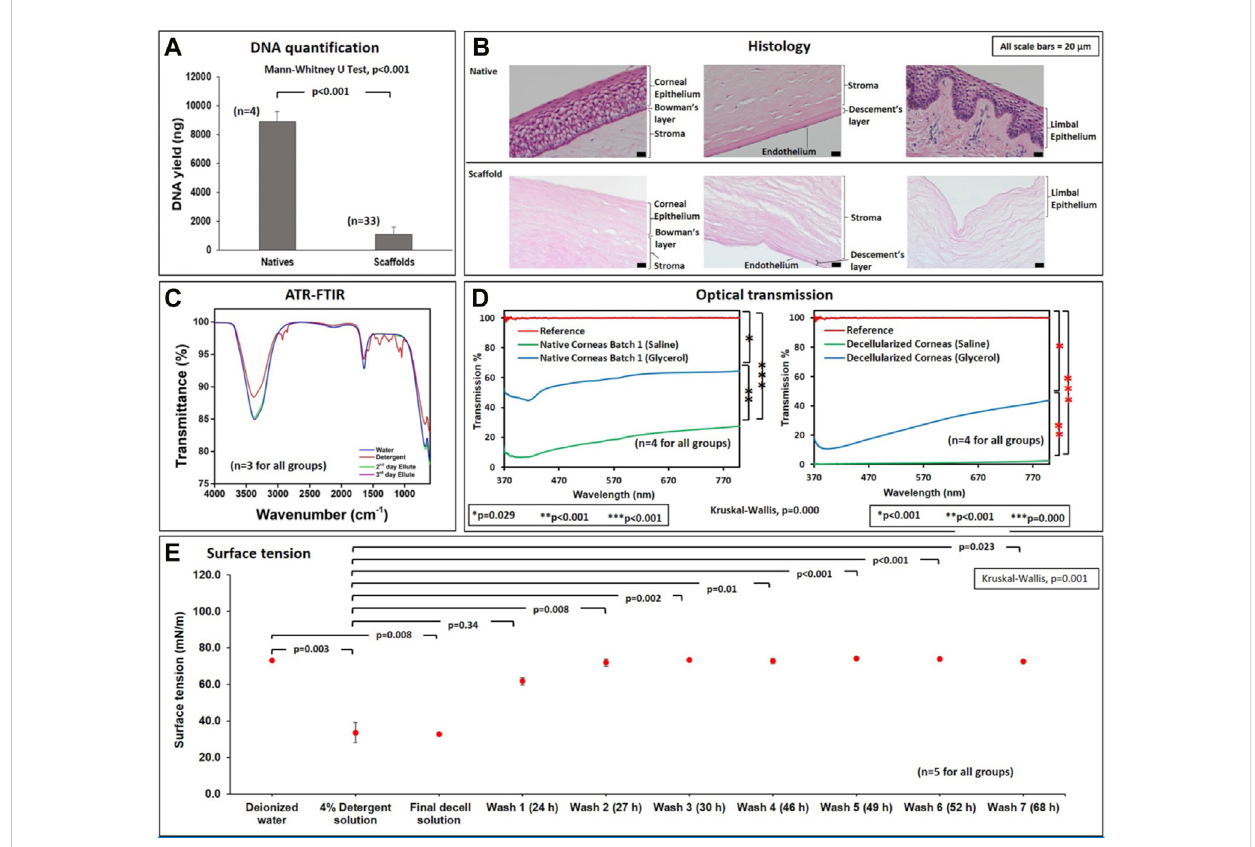
FIGURE 2 Biochemical, microscopic, and spectroscopic assessments of native and decellularized scaffolds. (A) A graphical representation of the relative DNA contents (ng DNA/ μ L of homogenized tissue) in native and acellular corneas. (B) Micrographs (from a ×20 objective) illustrate the effective removal and retention of extracellular matrix compartments in decellularized corneal scaffolds compared to native tissues. (C) FTIR assessments outline the effective removal of the detergent during the washout phase from the second and third day elutes. (D) Optical transmission studies verify the ability to retain viable degrees of ocular transparency in native and decellularized corneas, compared to the reference (glass slide), which roughly supports 100% light transmission. (E) Surface tension measurements of deionized water, 4% detergent, fi nal decell solution (collected at the end of the seventh day of the decellularization process), and washouts obtained for three consecutive days (wash 1 through wash